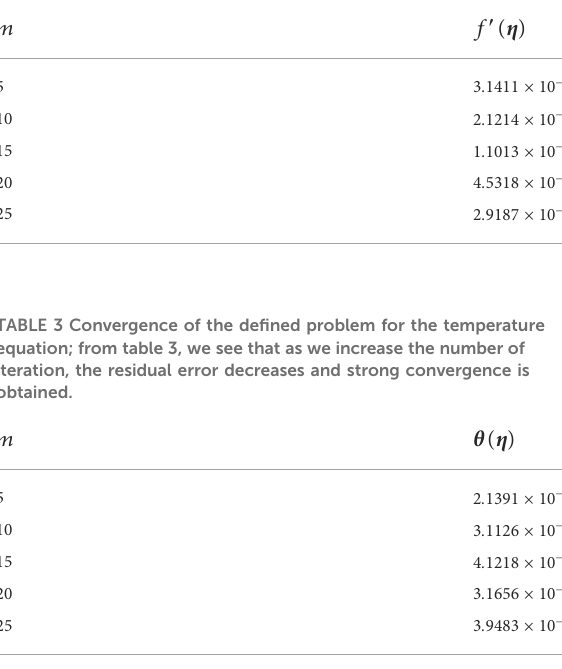
TABLE 6 OHAM and numerical comparison for f ( η )